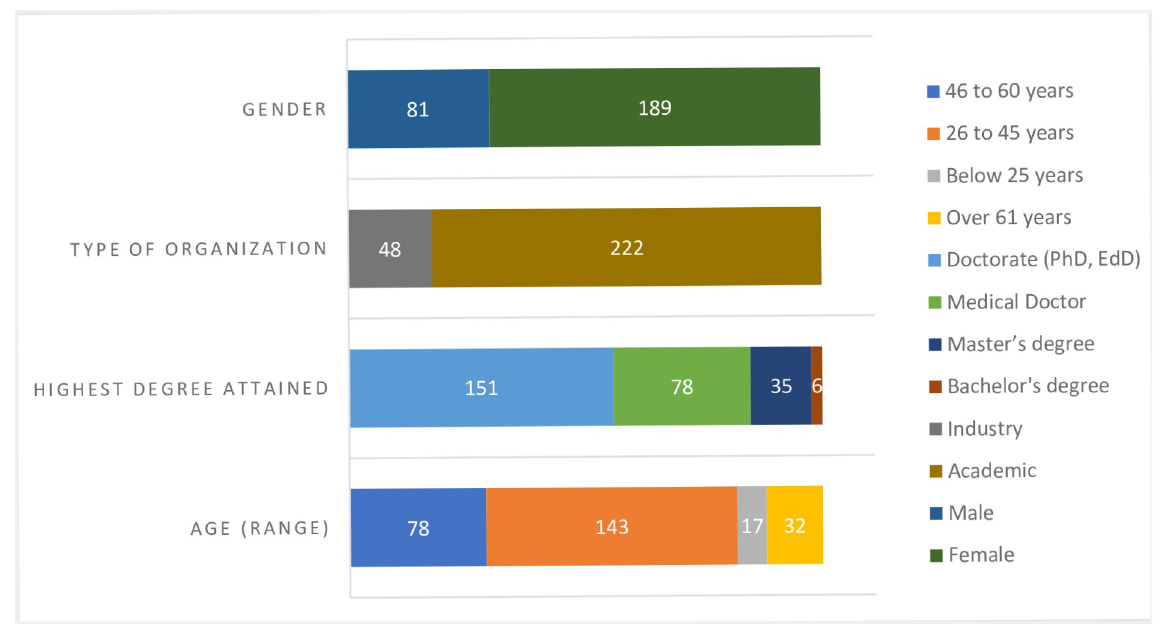
Fig 3. Demographic summary of study participants.